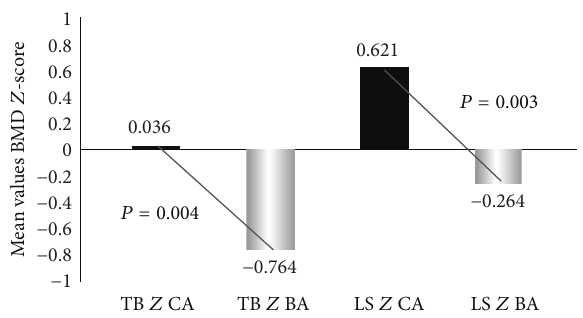
Figure 1: Total body and lumbar spine mean BMD Z -scores to chronological and bone ages. TB Z CA: total body BMD Z -score to CA, TB Z CA: total body BMD Z -score to BA. LS Z CA: